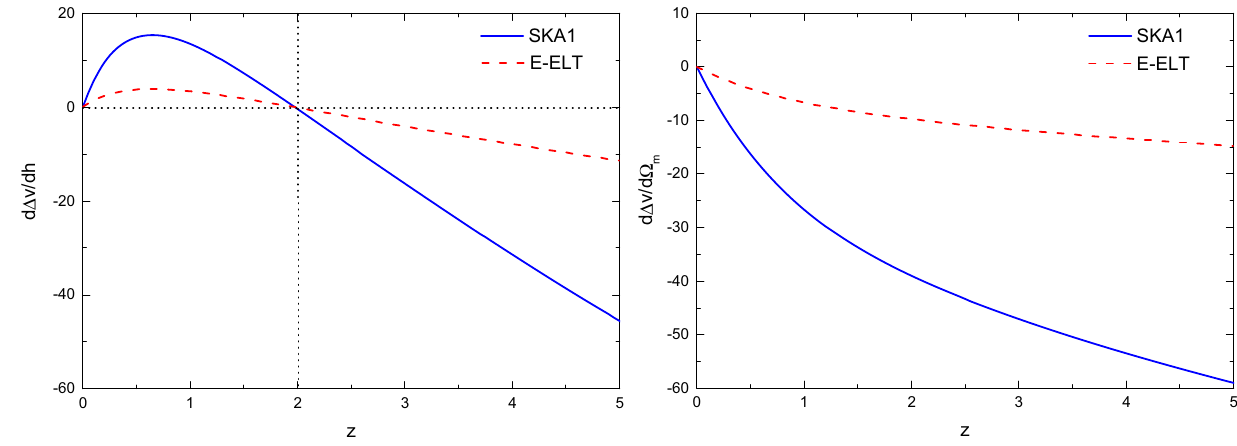
Fig. 3 Curves of d (cid:7)v/ dh versus z (left) and d (cid:7)v/ d (cid:4) m versus z (right) for E-ELT and SKA in the (cid:2) CDM model. Parameter values are set as in Fig. 1